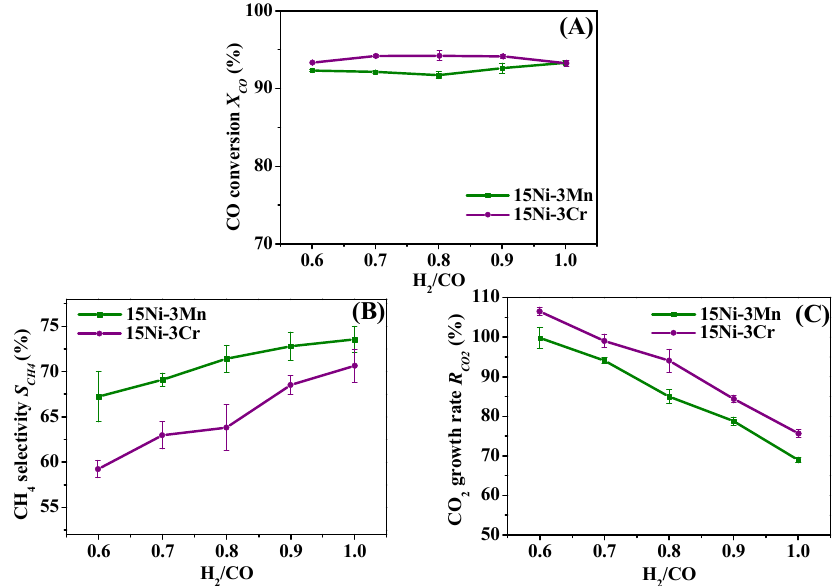
Figure 7. Effect of H 2 /CO on partial methanation coupling with WGS at 350 °C and H 2 O/CO = 1: ( A ) CO conversion; ( B ) CH 4 selectivity; and ( C ) CO 2 growth rate.